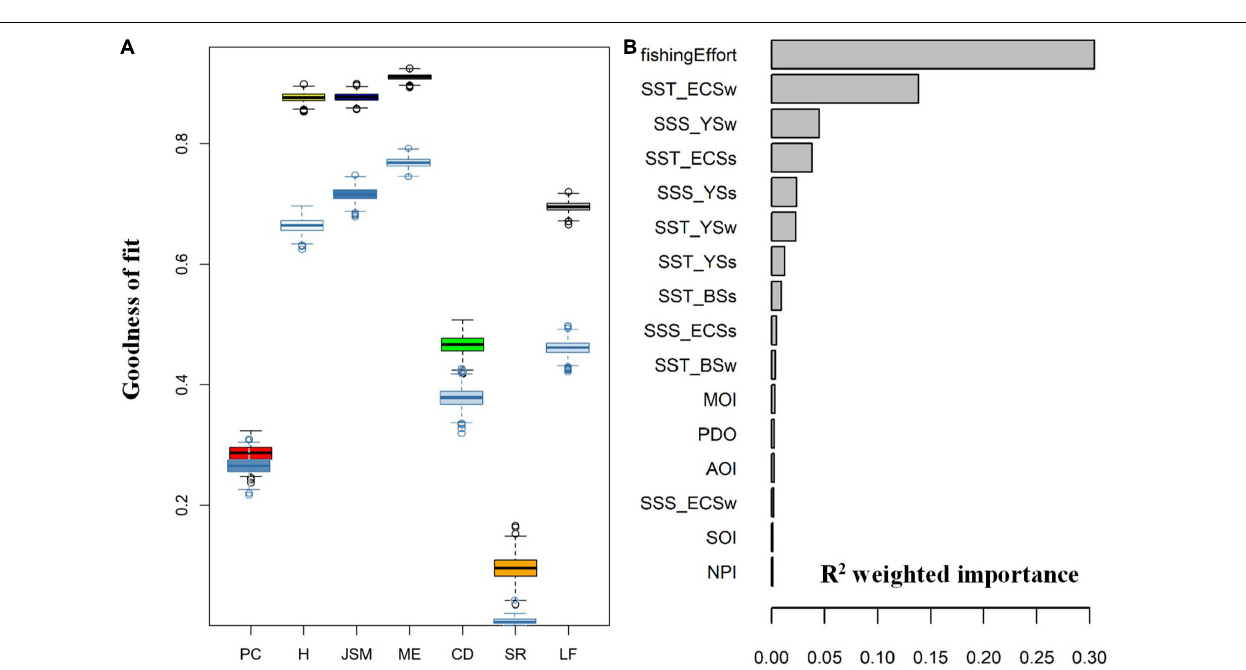
trends, although the overall catch levels are lower from the latter. Both catch data correspond well with changes in fishing effort that increased rapidly from the 1980s to 1990s